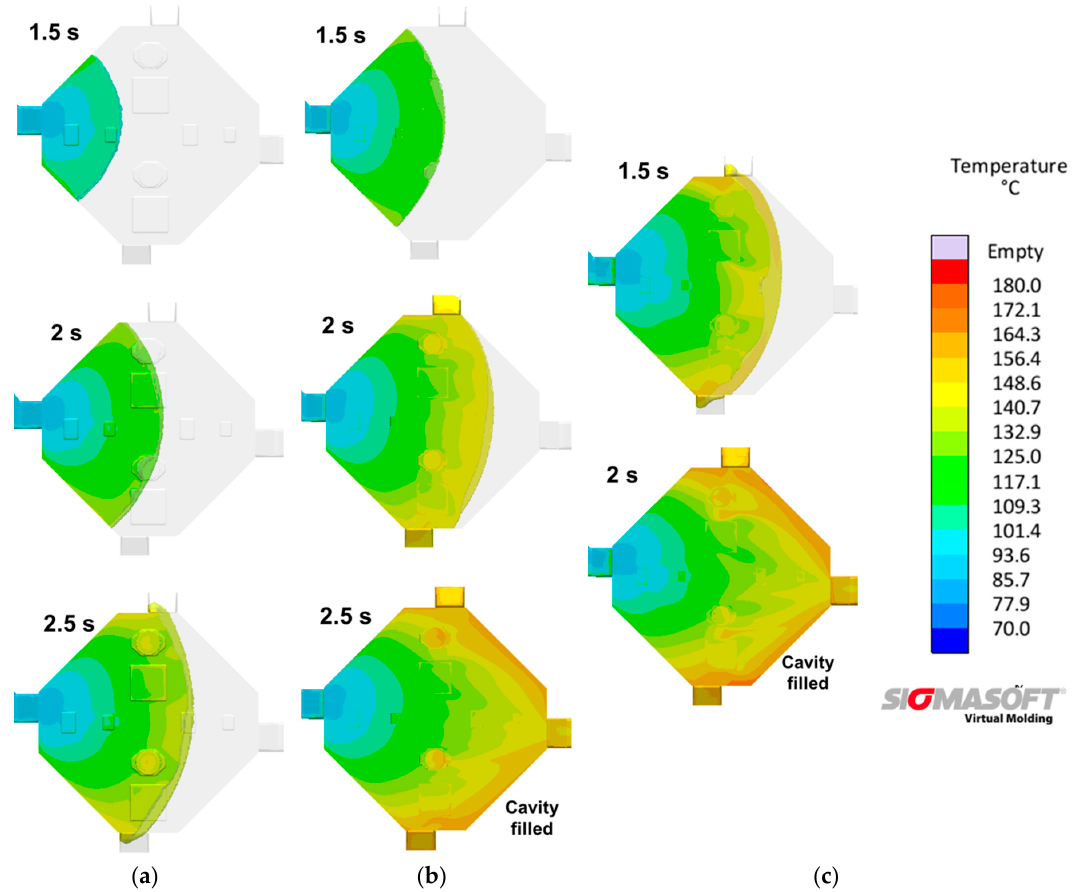
Figure 7. Comparative fill behavior from the simulation for ( a ) 1 mm, ( b ) 0.5 mm, and ( c ) 0.25 mm encapsulation thickness.